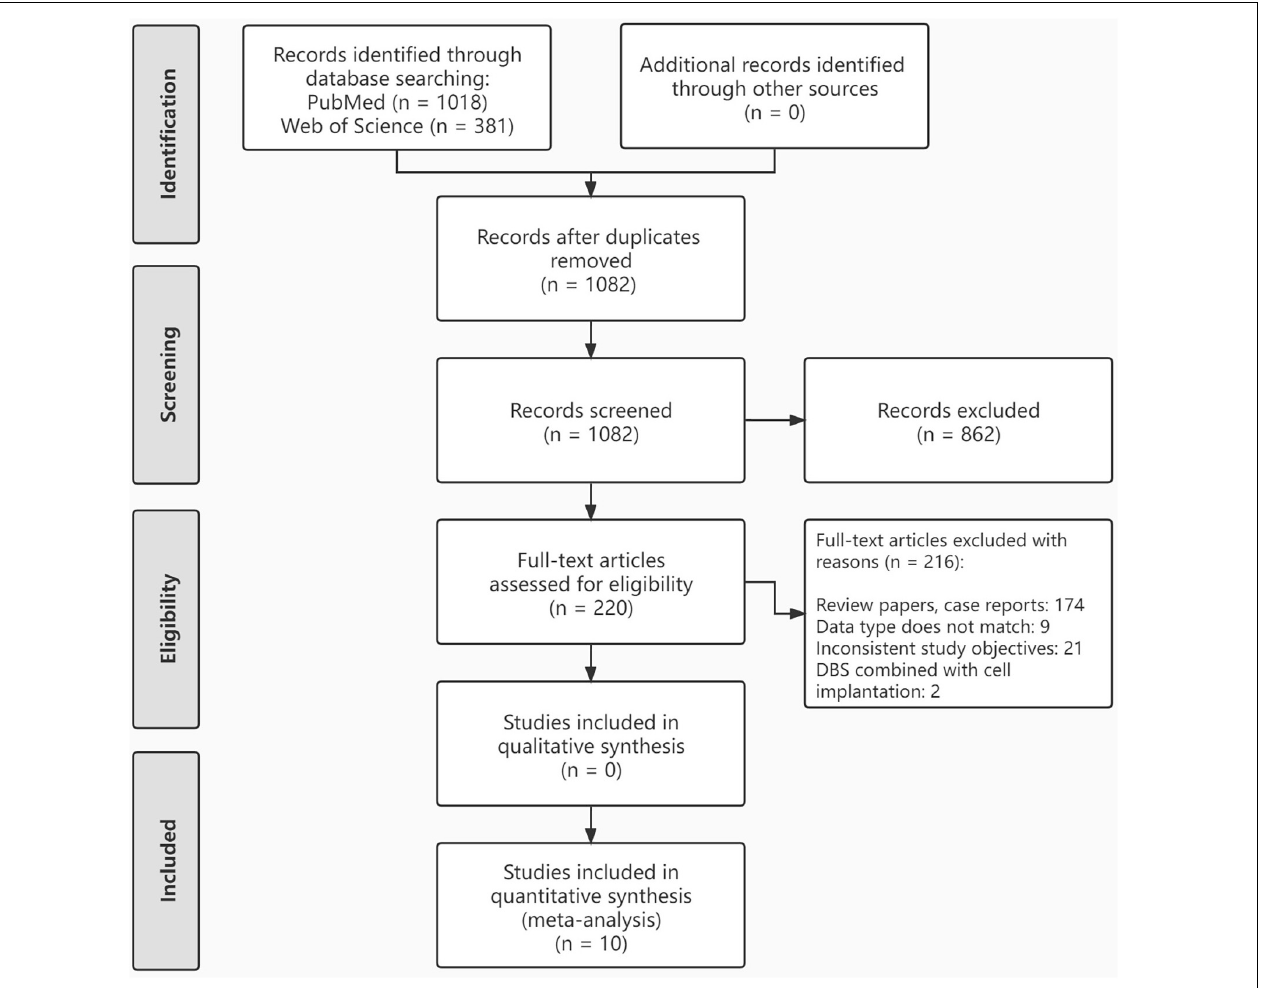
FIGURE 1 | Flow chart of the study